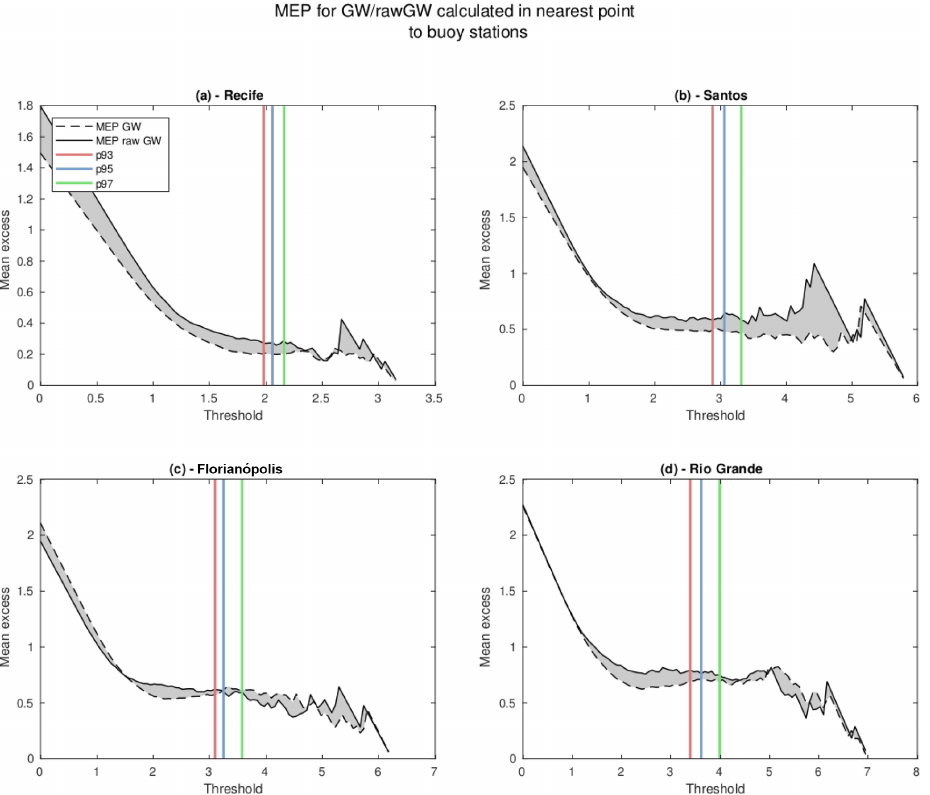
Figure 2. Comparison of mean excess plot (MEP) for Recife, Santos, Florianópolis and Rio Grande. The thresholds correspondent to 93%, 95% and 97% (red, blue and green vertical lines, respectively) are